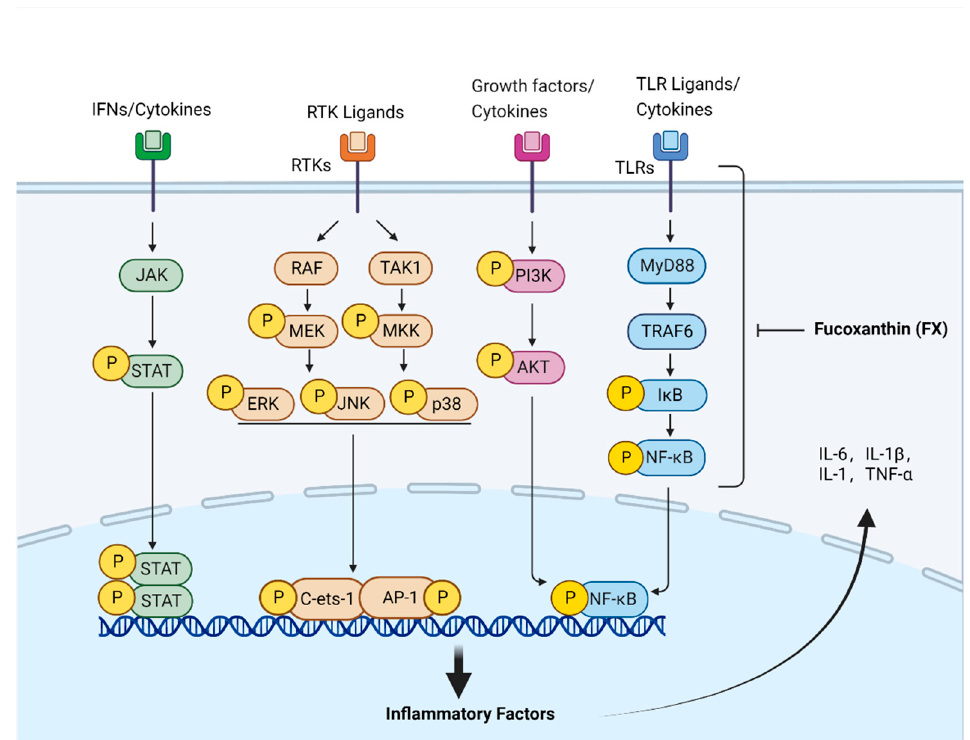
Figure 2. Pathway underlying fucoxanthin ‐ associated anti ‐ inflammatory effects. The development and progression of inflammation is accompanied by the activation of JAK/STAT, MAPK, PI3K/AKT, TLR4/MyD88/NF ‐κ B and other related signaling pathways. FX can inhibit the signal transduction of these inflammatory pathways and down ‐ regulate the expression of inflammatory factors such as IL ‐ 6, IL ‐ 1 β , IL ‐ 1, and TNF ‐α , thereby achieving the anti ‐ inflammatory effect.